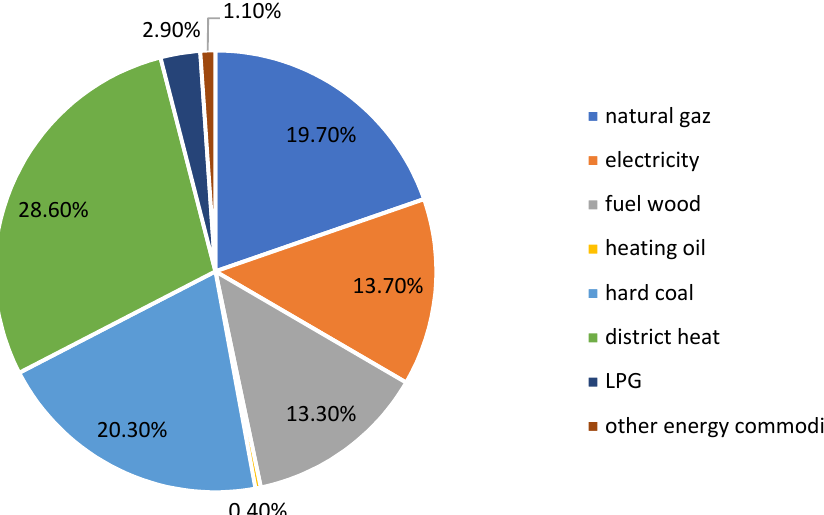
Figure 2. Structure of energy consumption in households per capita, broken down by individual energy carriers in 2021.